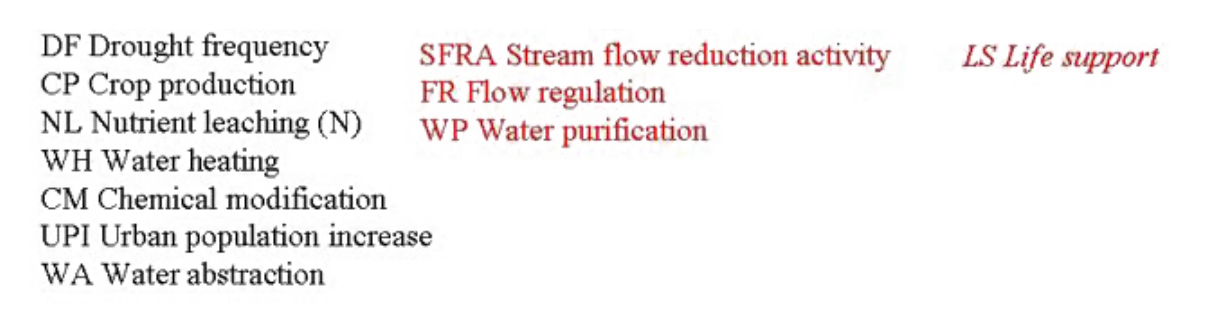
Fig. 4 . ARDI stage 3 at Crocodile River: “What are the main processes that drive changes in the Crocodile Catchment that affect the river flow?” Words or concepts written in red were added during the later steps of the ARDI. Words written in italics were proposed by the facilitator to get out of a